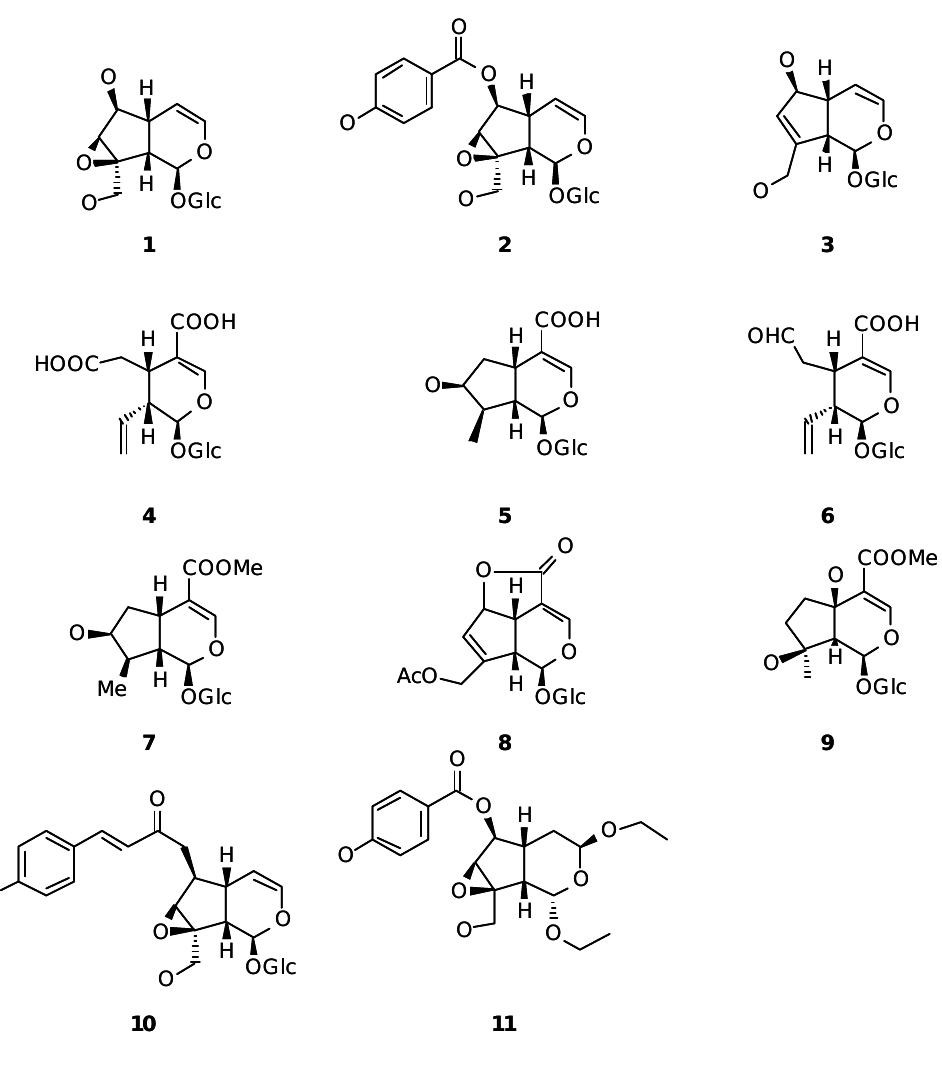
Figure 1 . Examples of Bignoniaciae